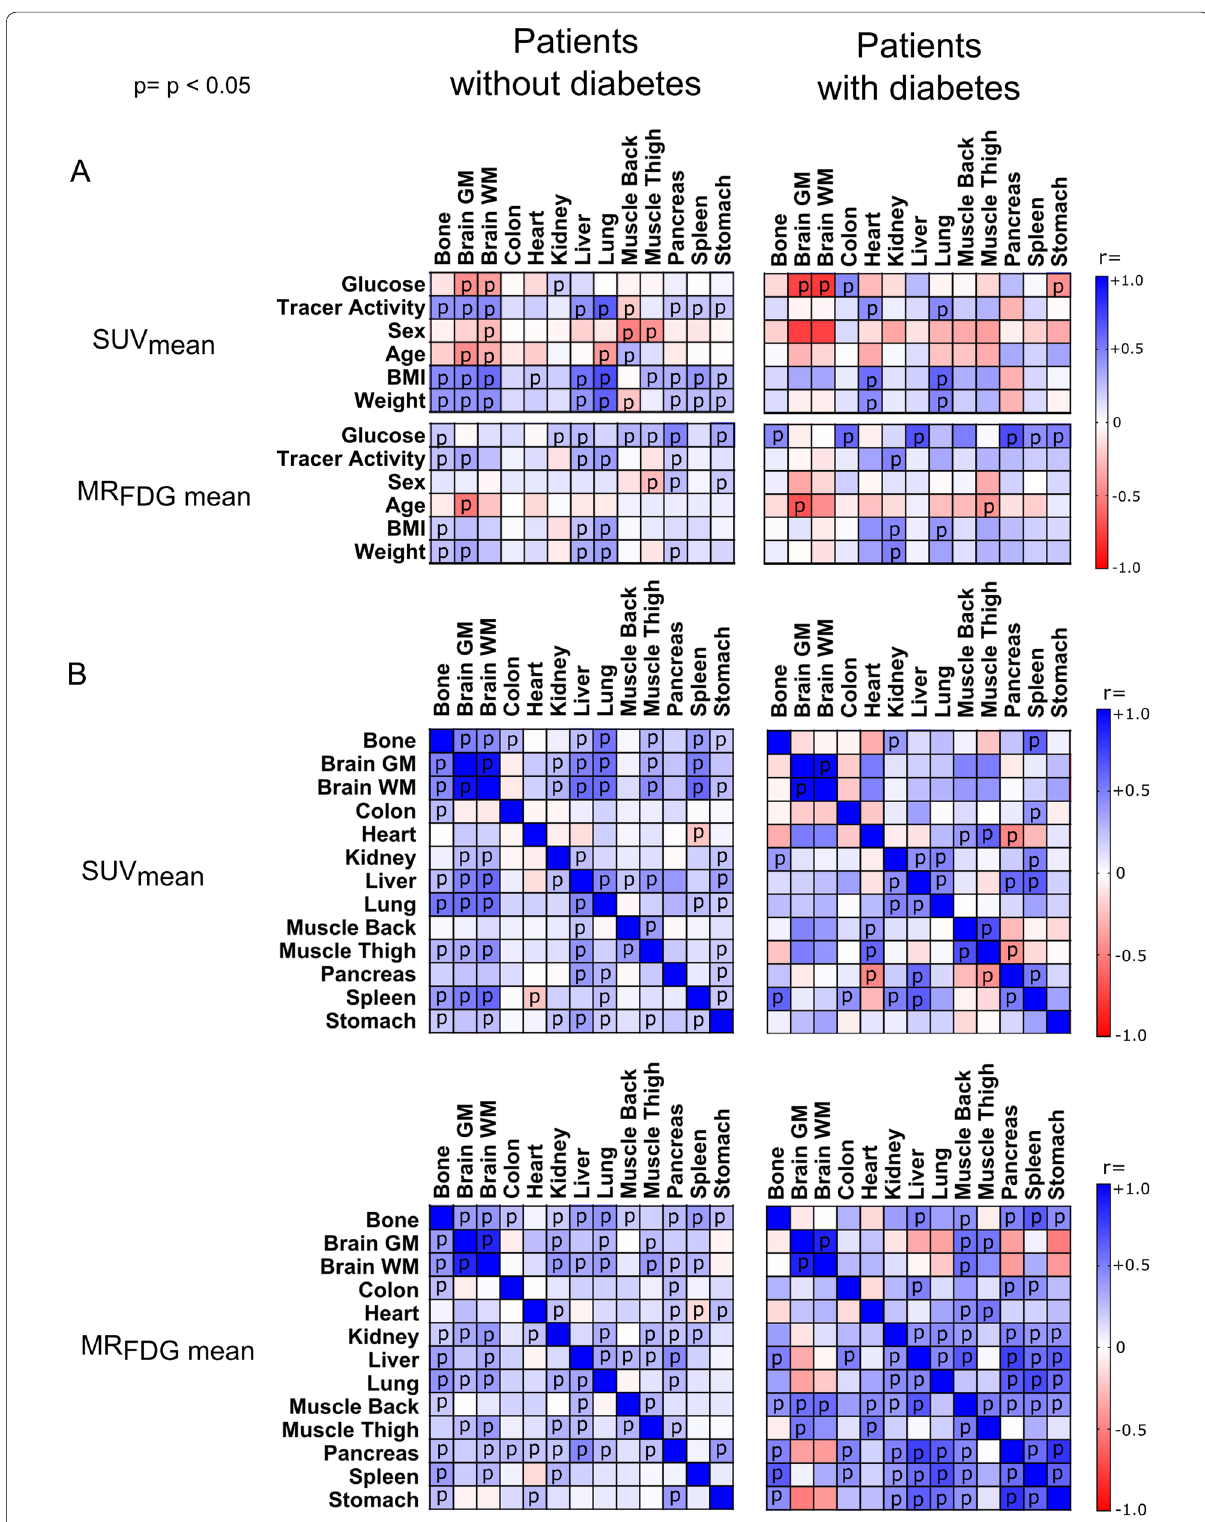
Fig. 7 Pearson’s correlation analysis of patients with and without diabetes, of SUV mean and MR FDG mean with glucose levels, tracer activity, sex, age, BMI, and weight ( A ); as well as between paired sets of organs ( B ). Cells labelled “p” showed statistically significant correlation ( p < 0.05) without correction for multiple comparisons. The full correlation results can be found in the Additional file 1: figure S1 and S2, table S4A, S4B, S5A and